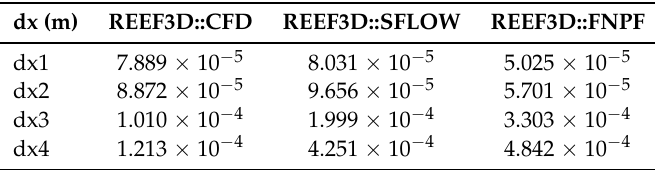
Table 2. Mean square root errors on wave height in the grid convergence study for the 2D regular linear wave simulation using the three modules. The notations dx1 to dx4 represent the finest and coarsest cell size in the tests of each of the modules.